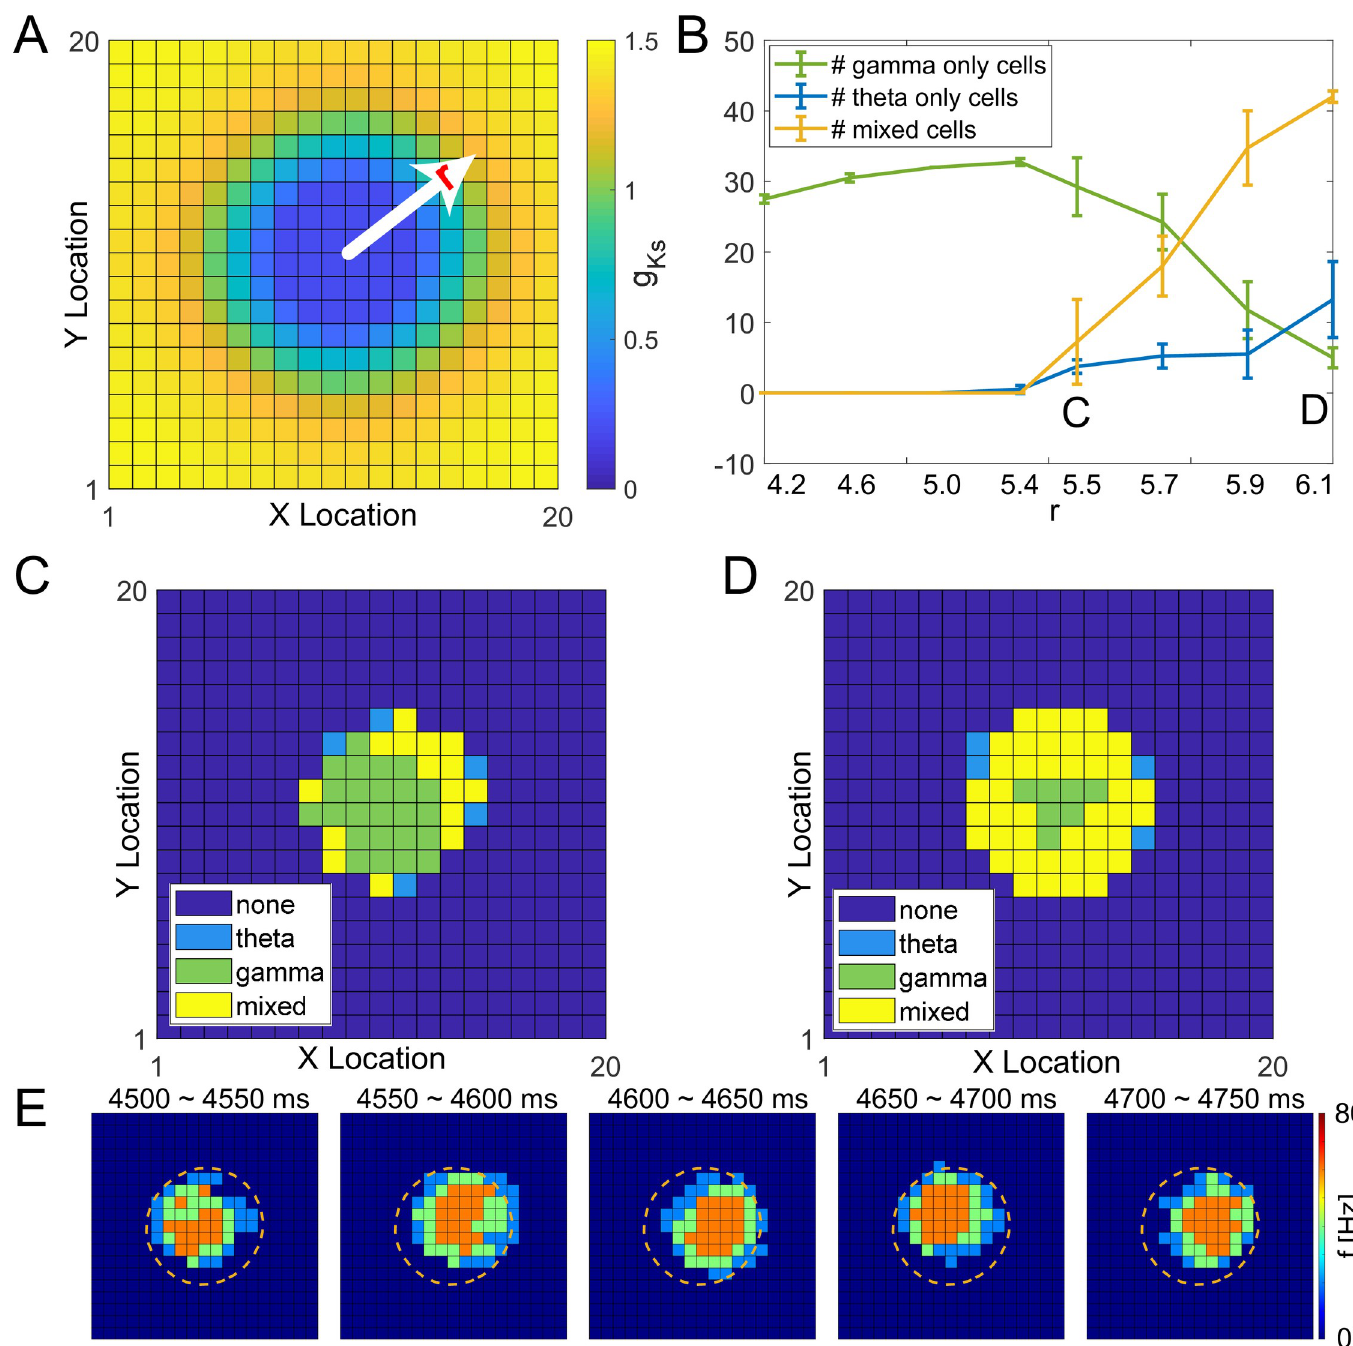
Fig 3. Gamma and theta band cell firing with a single peak g Ks distribution. A, Example single peak g mapping projected on the 20 × 20 E cell lattice where r indicates Ks the radius of the approximately circular region (hotspot) with low g Ks values. B, The number of neurons primarily exhibiting gamma (green curve), theta (blue curve) and hotspot. C, D, Dominant rhythmic activity of individual E cells (dark blue = none, light blue = theta mixed rhythms (yellow curve) as a function of the radius of the g Ks band, green = gamma band and yellow = mixed, both gamma and theta) plotted at cell position on the E cell lattice for g Ks hotspot radius of r = 5.5 and r = 6.1, respectively. hotspot radius r = 6.1). Cells inside the orange contour lines have g E , Snapshots of E cell firing activities from 4500–4750 ms during the simulation shown in D ( g Ks K s values less than 0.6 mS/cm 2